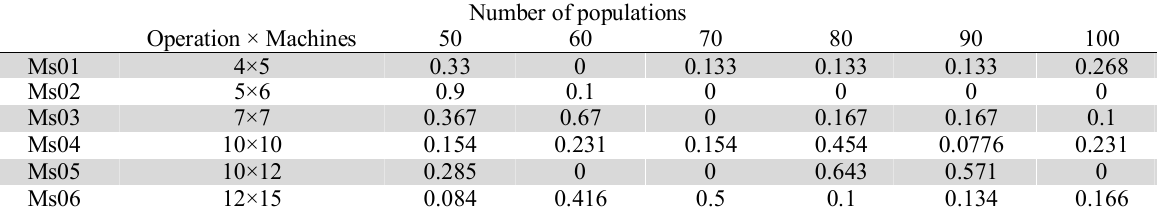
P Computational results for 6 problems Yi